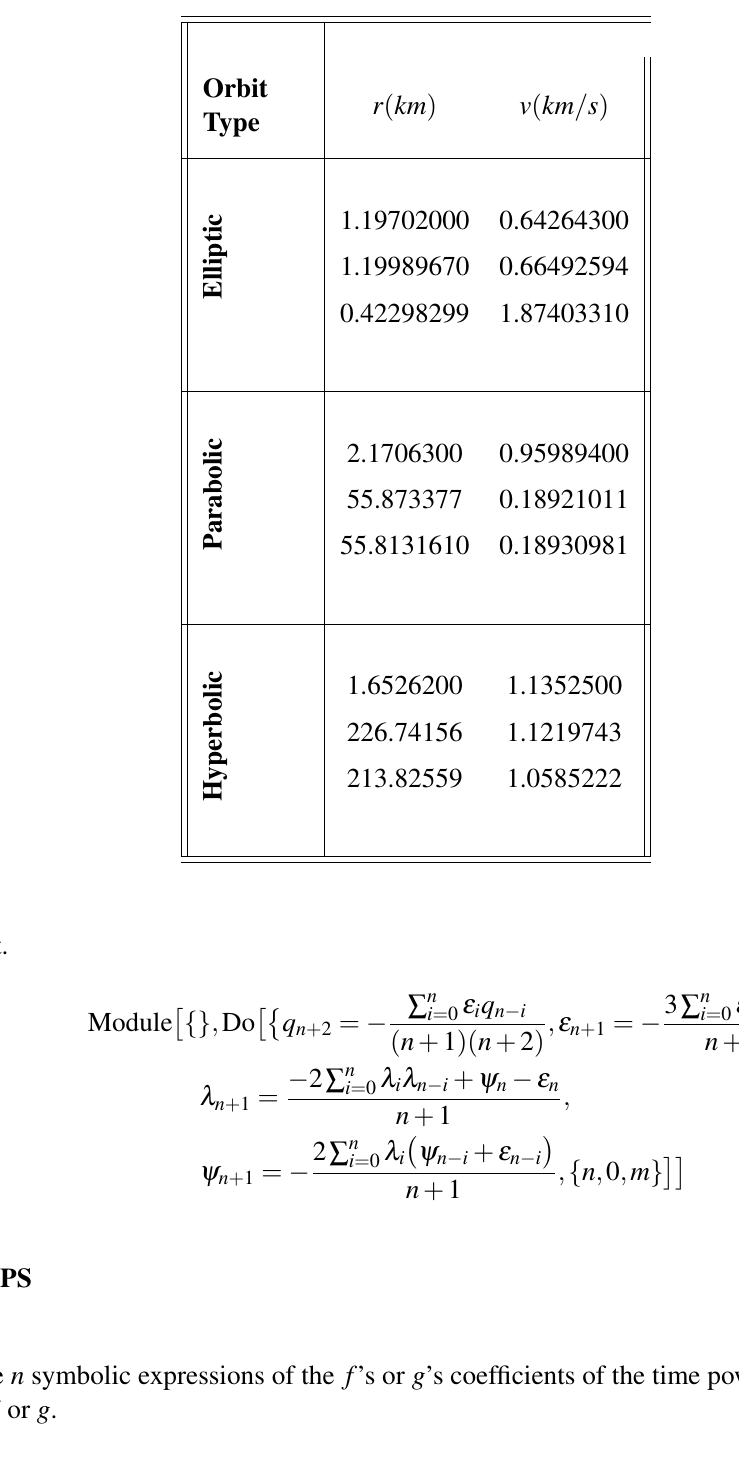
Table 2 The final scalar values of the position and velocity